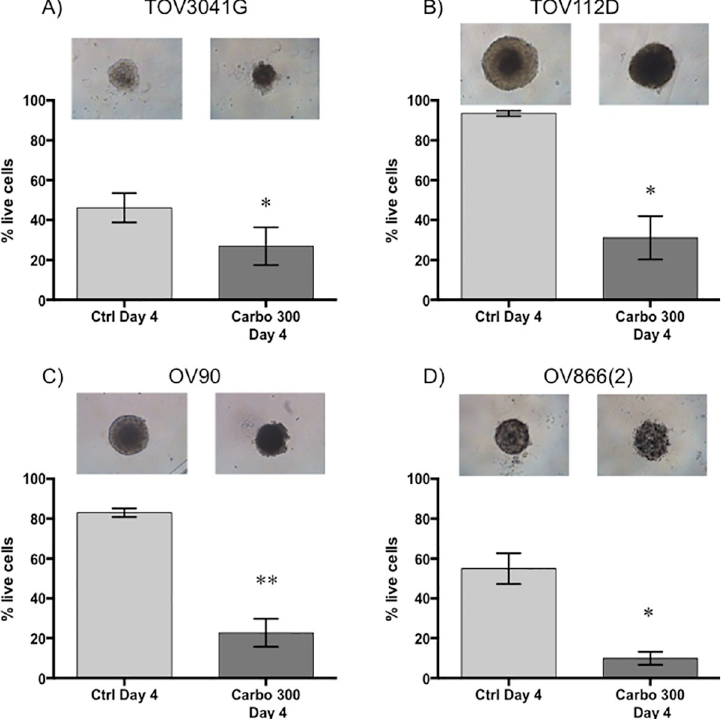
Fig 5. Carboplatin response of EOC spheroids cultured with 2% matrigel in ultra-low attachment wells. 3D spheroids of TOV3041G (A), TOV112D (B), OV90 (C) and OV866(2) (D) were formed and cultured in concave- bottom ULA plates in the presence of 2% Matrigel for 4 days (Ctrl Day 4) or treated at day 2 with 300 μ M of carboplatin and assessed at day 4 (Carbo 300 Day 4). Top panels are representative microscopic bright field images of each condition. Bar graphs represent cell survival analysed by flow cytometry of control (light grey) and treated (dark grey) spheroids. Data are shown as the mean ± SEM of three independent experiments. � p < 0.05; �� p < 0.005 (Student’s